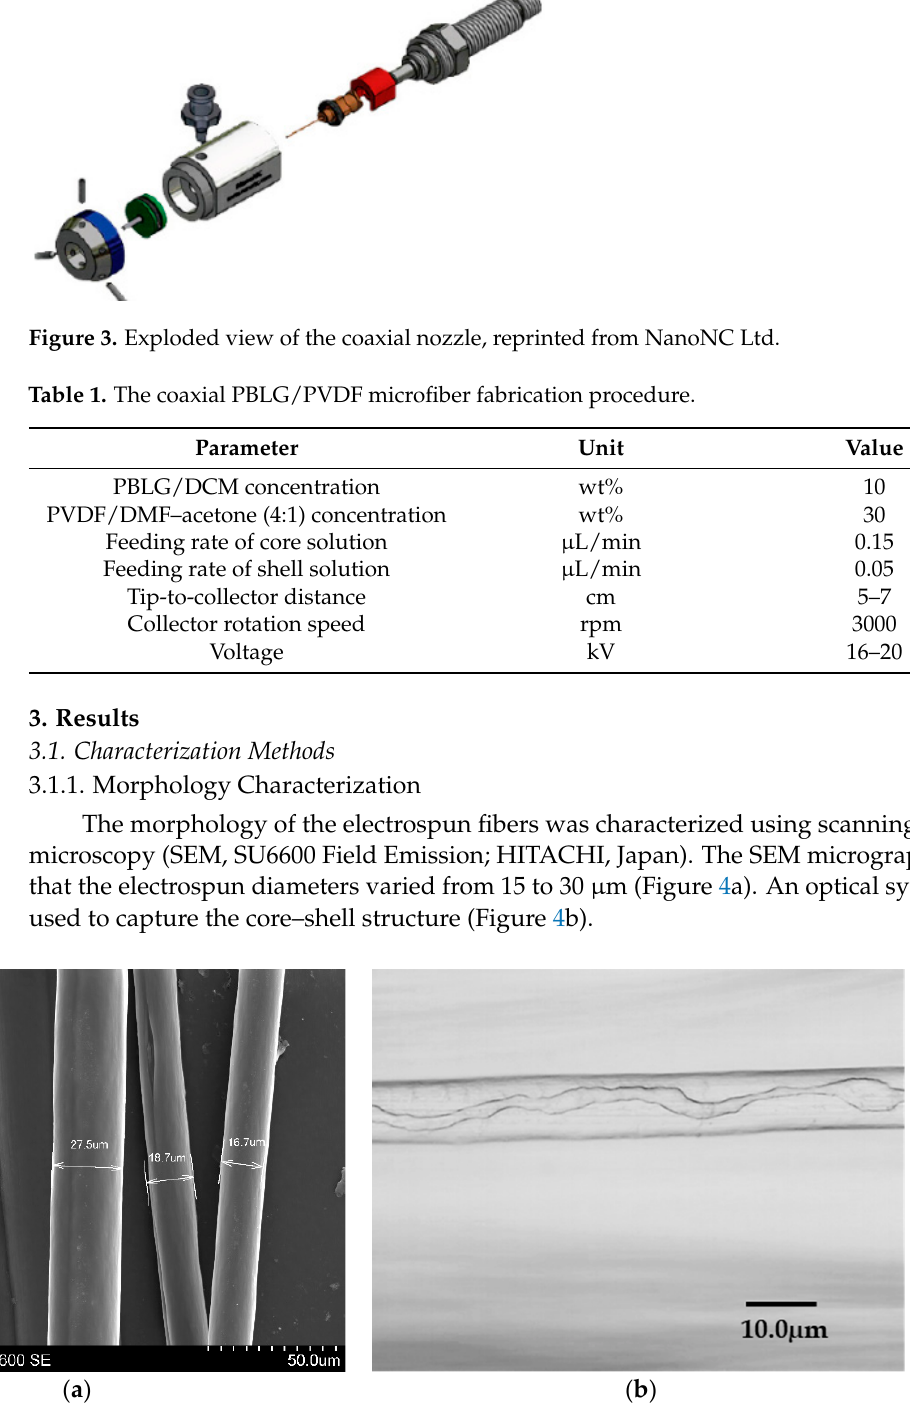
Figure 4. ( a ) The SEM micrograph of electrospun PBLG/PVDF fibers and ( b ) the core–shell structure.